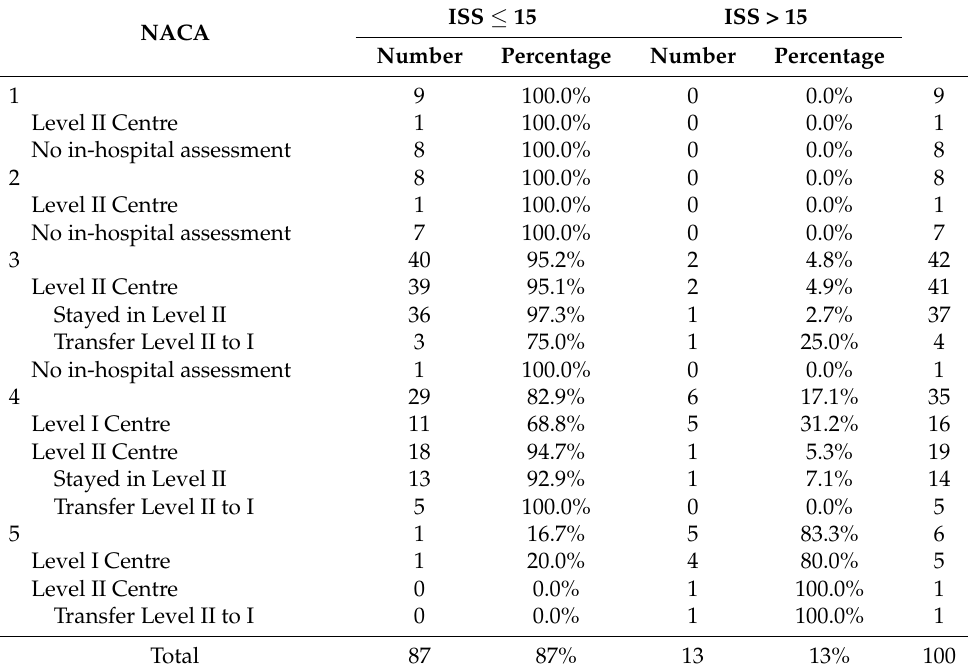
Table 3. Numbers of NACA patients according to initial hospital dispatching and to